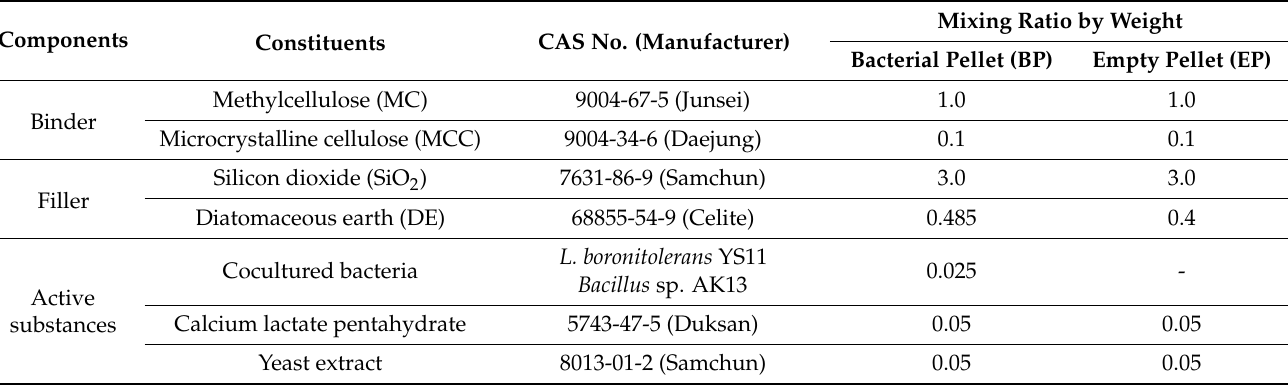
Table 1. Pellet materials and their mixing